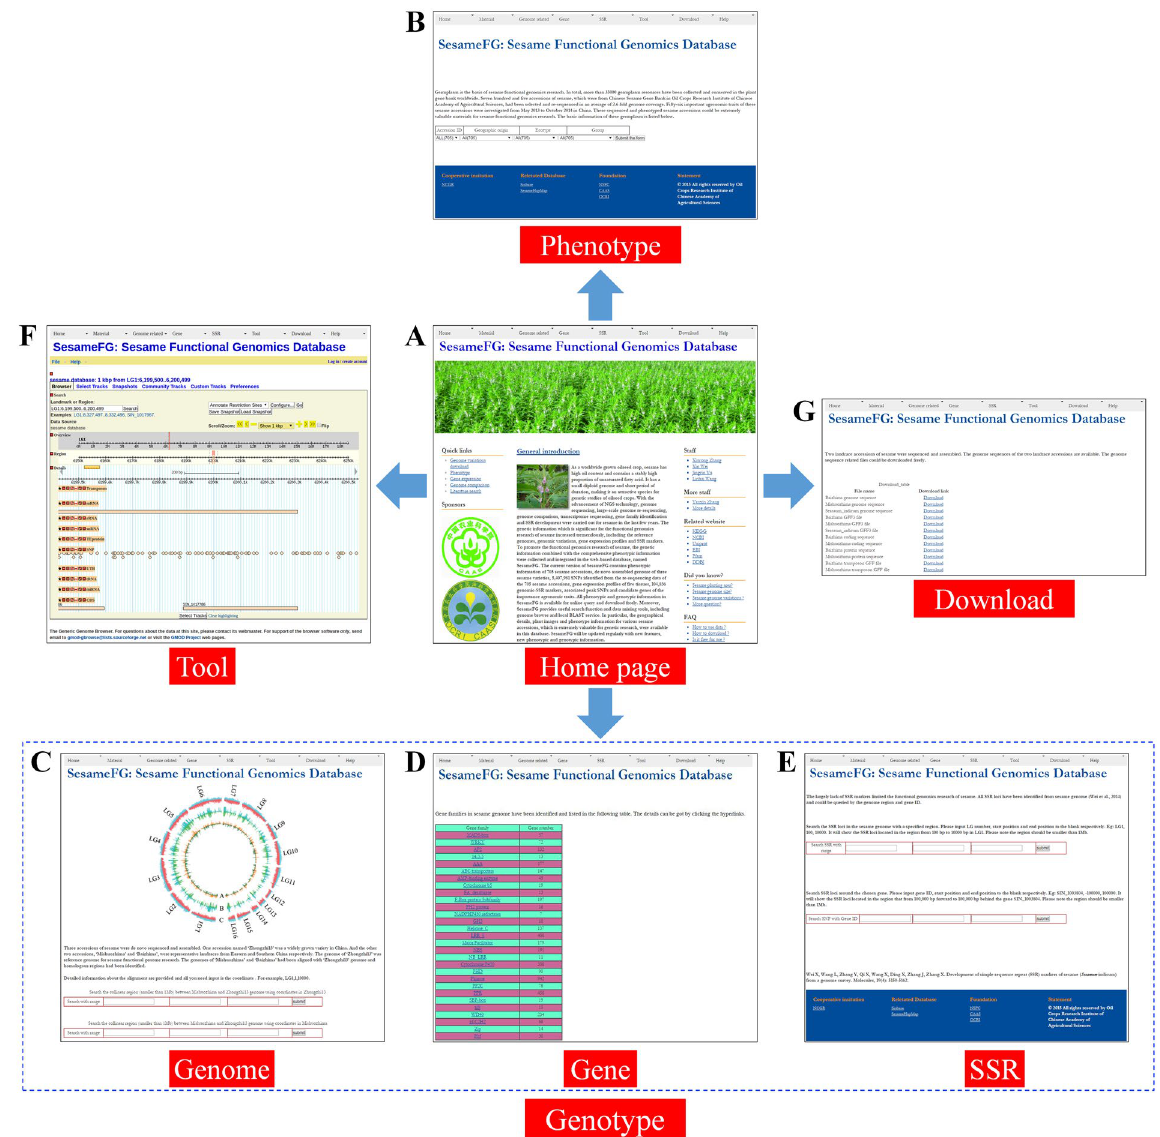
Figure 2. Main contents and interfaces of SesameFG. ( A ) The home page of SesameFG. ( B ) Basic information of the 705 sesame germplasm. ( C ) Collinear regions and genome variations in sesame genomes. ( D ) Gene families identified from the sesame genome. ( E ) SSR loci identified from the sesame genome. ( F ) The Genome Browser for locating gene structures, SNPs, and RNAs. ( G ) Genome variations of 705 sesame accessions for